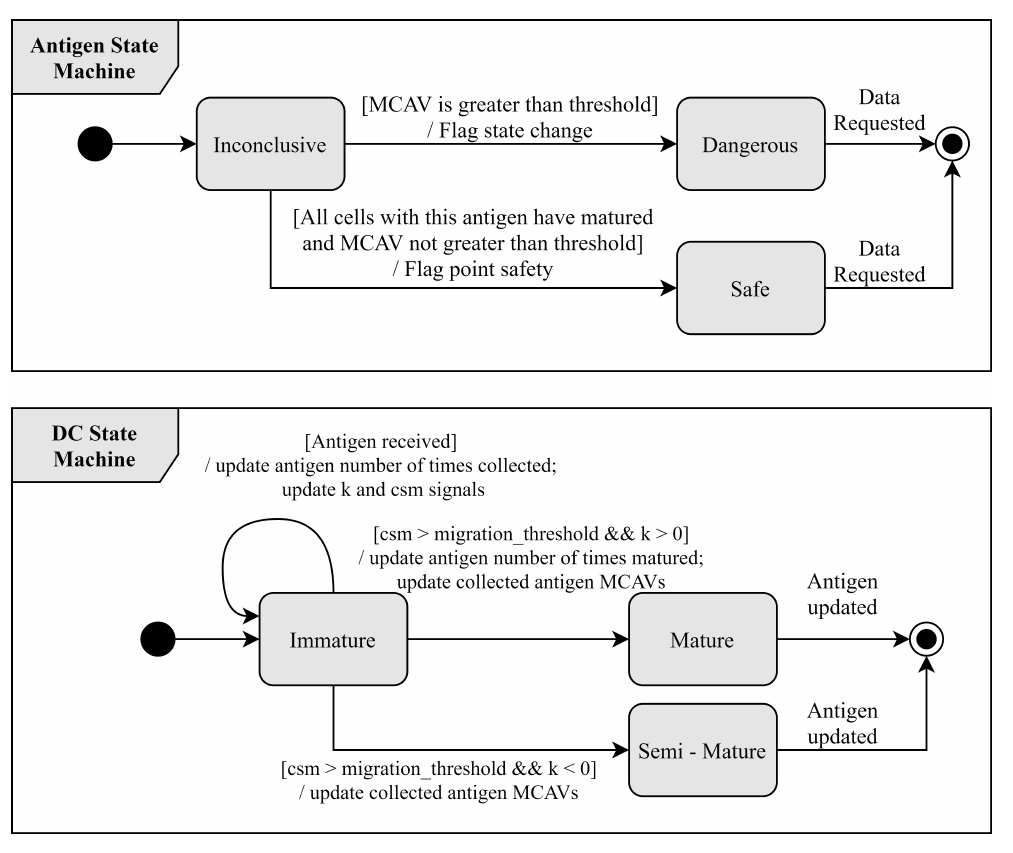
Figure 8. Antigen and dendritic cell state changes. As dendritic cells mature, they increment dendritic cell count in collected antigens , and update their Multi Context Antigen Value ( MCAV